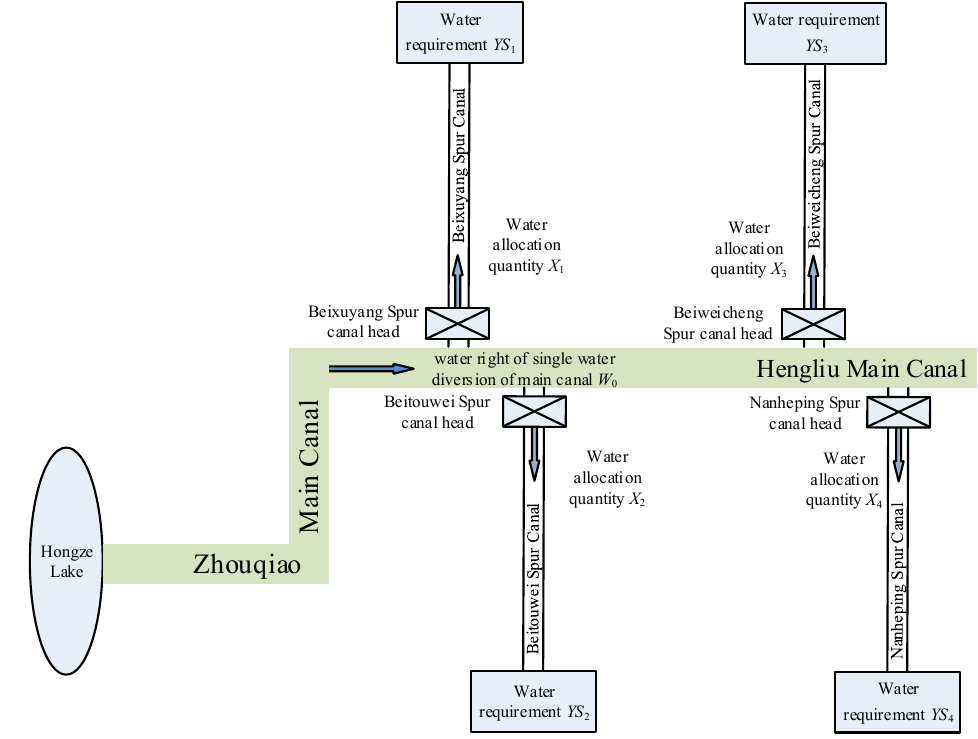
Figure 1. System generalization of the water receiving area controlled by the Hengliu Main Canal. Table 1. Basin information of the Hengliu Main Canal.